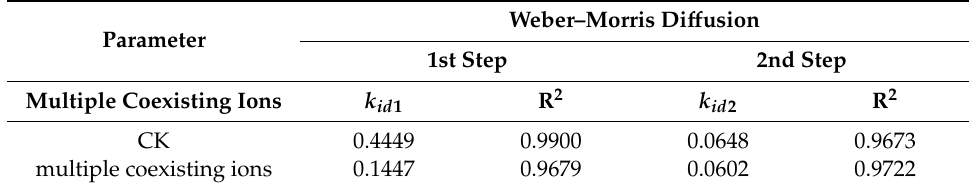
Table 7. The adsorption kinetic model rate constants for the As (V) on NZVI / AC in the presence of multiple coexisting ions.